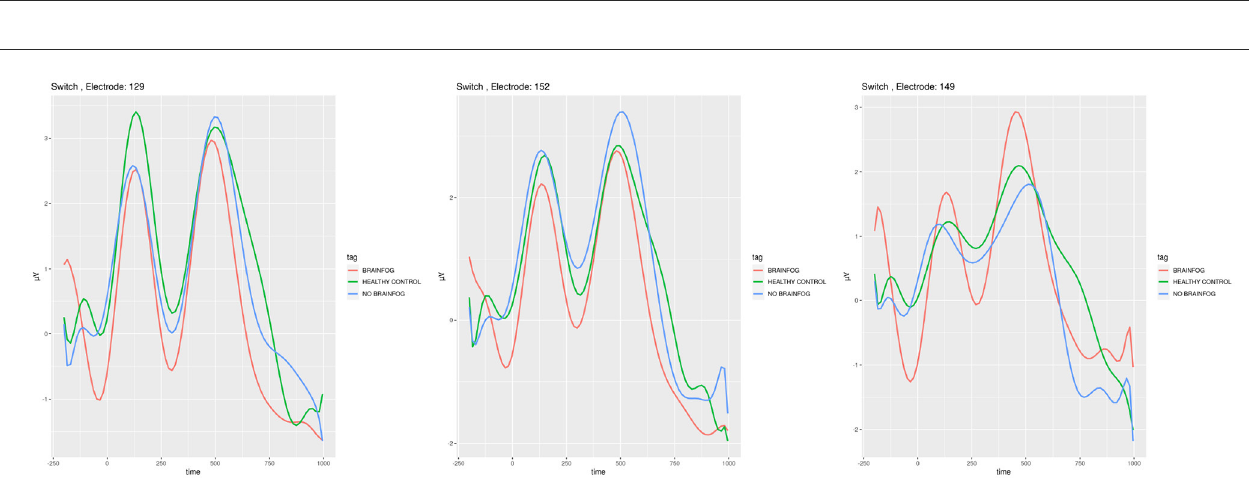
FIGURE7 ERP plots generated for the electrodes E129 , E152 , and E149 that showed the smallest cross-correlation in the task-switching experiment when the participants saw digits . Red line—the participants that suffered from COVID-19 and with brain fog symptoms. Blue line—the participants that suffered from COVID-19 and without brain fog symptoms. Green line—the participants without COVID-19 episode. See also Tables 11–13 in Appendix A.